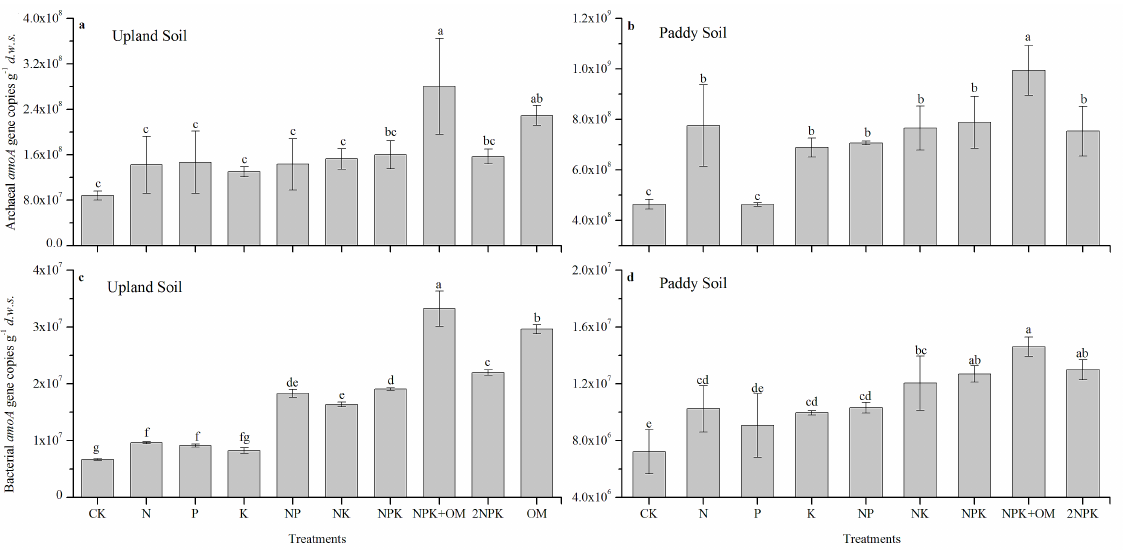
plots. Values are the means of the three replicated field plots. Different letters following values within the same column indicate significant differences among the treatments ( P < 0 . 05 ).